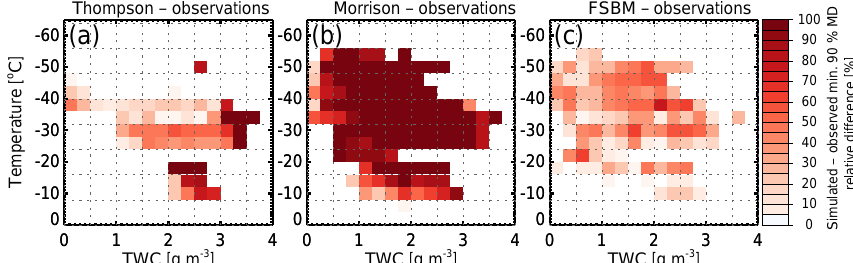
Figure 8. Joint histograms of positive relative differences between observed and simulated minimum 90% MDs as a function of TWC– T bins for (a) Thompson, (b) Morrison, and (c) FSBM